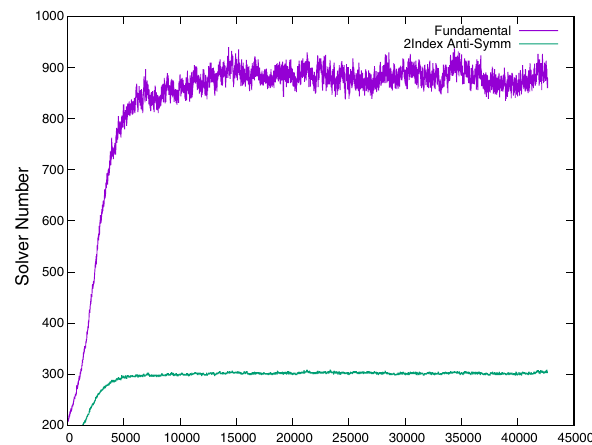
Fig. 3 Comparison between conjugate-gradient-solver iterations for the fundamental and the two-index antisymmetric representation at degenerate bare fermion masses am 4 = am 6 = − 0 . 55. As expected, the Dirac operator in the fundamental representation at a fixed value of the bare mass has smaller eigenvalues than the one in the sextet rep- resentation. The Dirac operator for the fundamental representation is then more ill-conditioned than its sextet counterpart and requires more solver iteration to reach the same